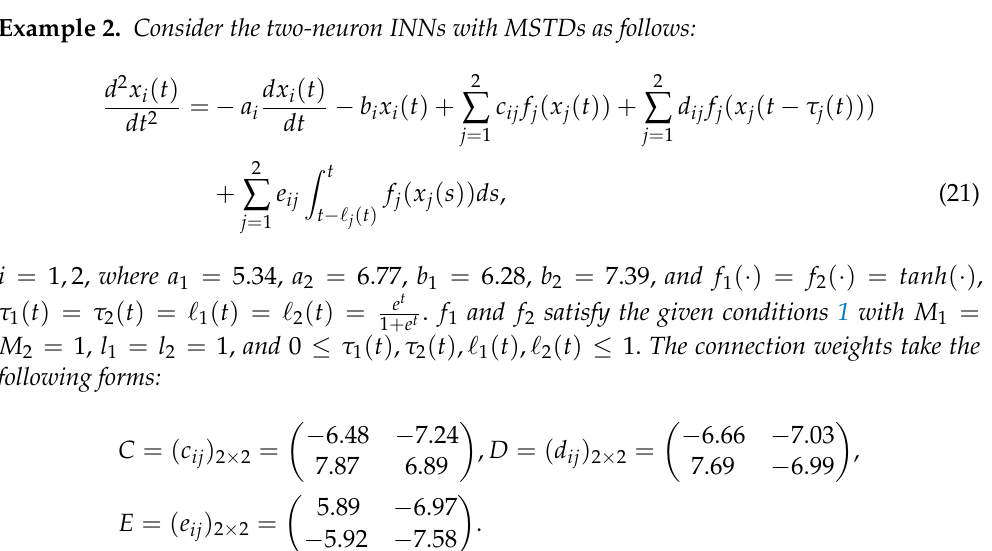
Figure 3. State behaviors of INNs (20) with a delay-dependent reliable state-feedback controller (7).